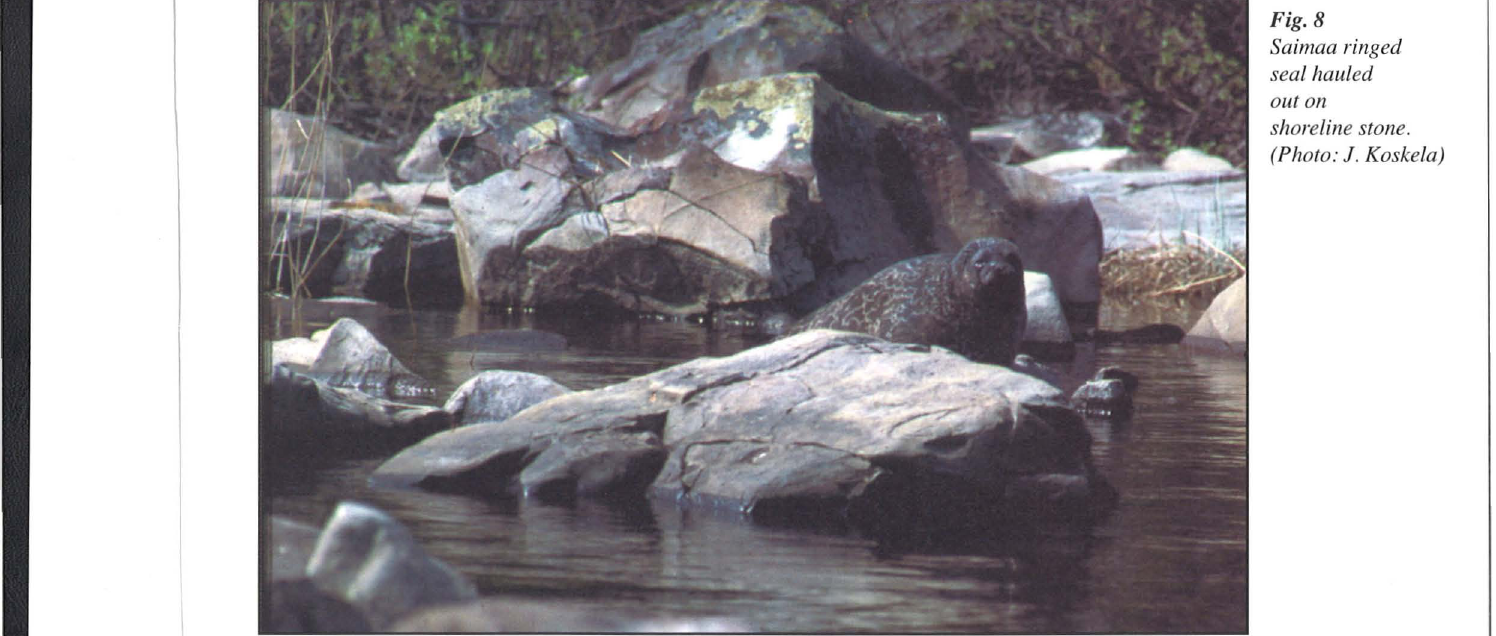
Fig. 8 Saimaa ringed seal hauled out on shoreline stone.